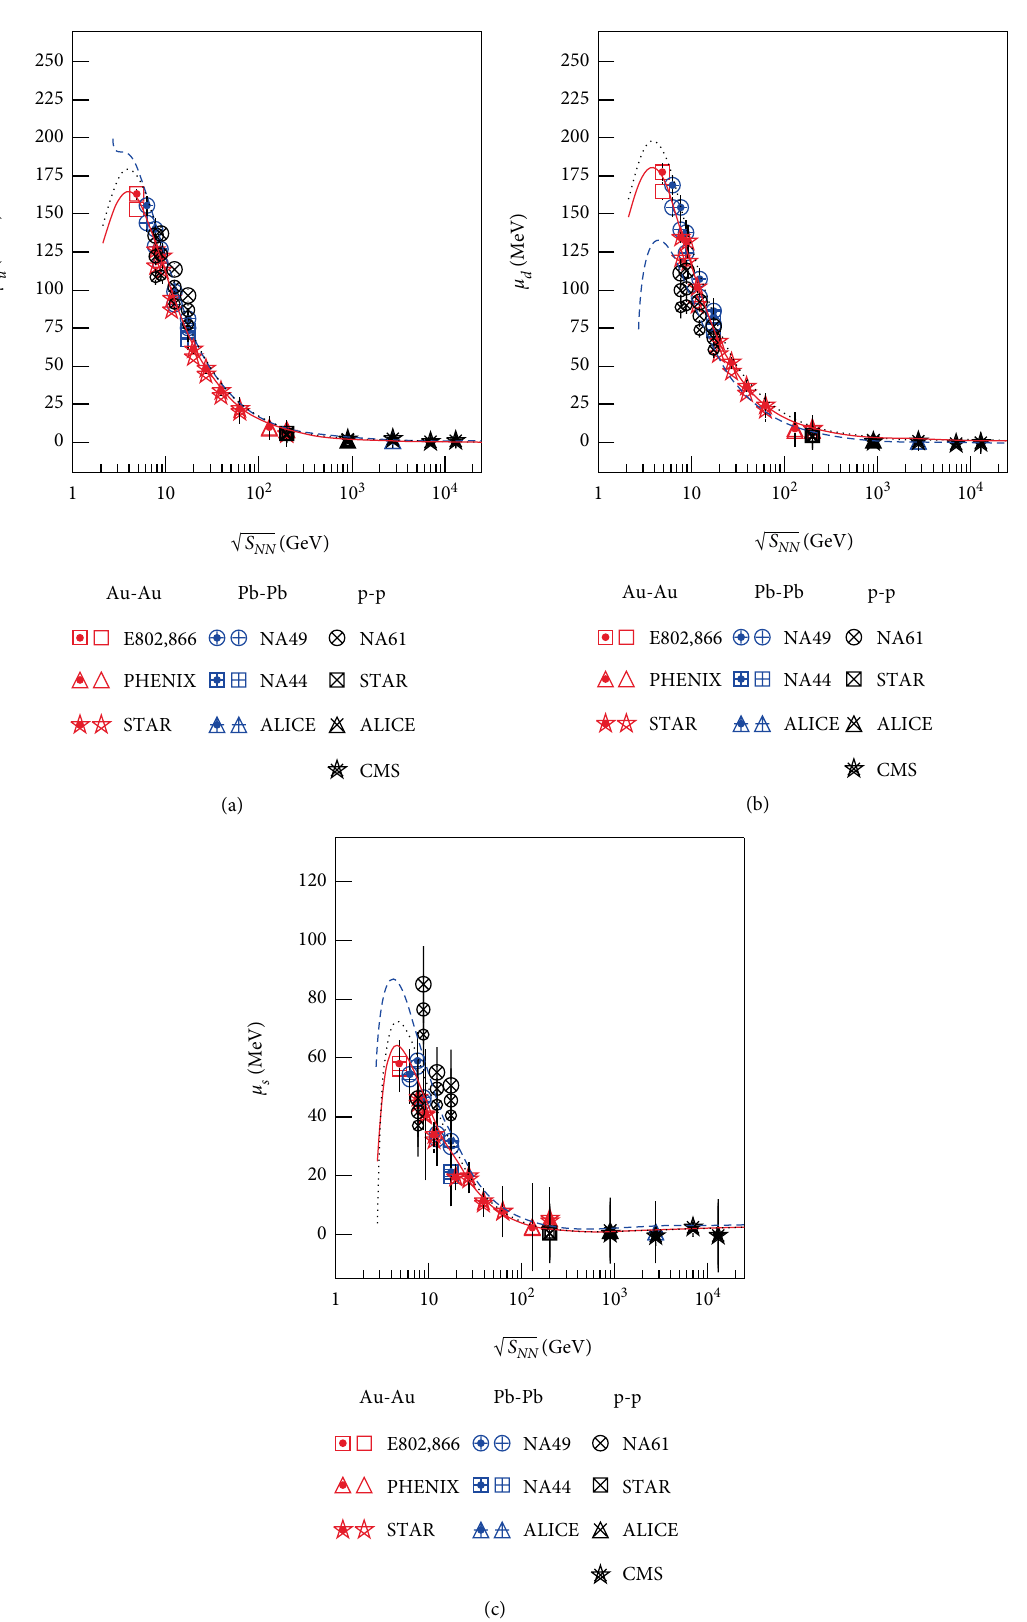
Figure 3: The same as Figure 2, but showing the chemical potentials, (a) Equation (6). The solid (dotted) and dashed curves are for central Au-Au (Pb-Pb) collisions without (with) the corrections of decays and for collisions INEL or NSD 𝑝𝑝